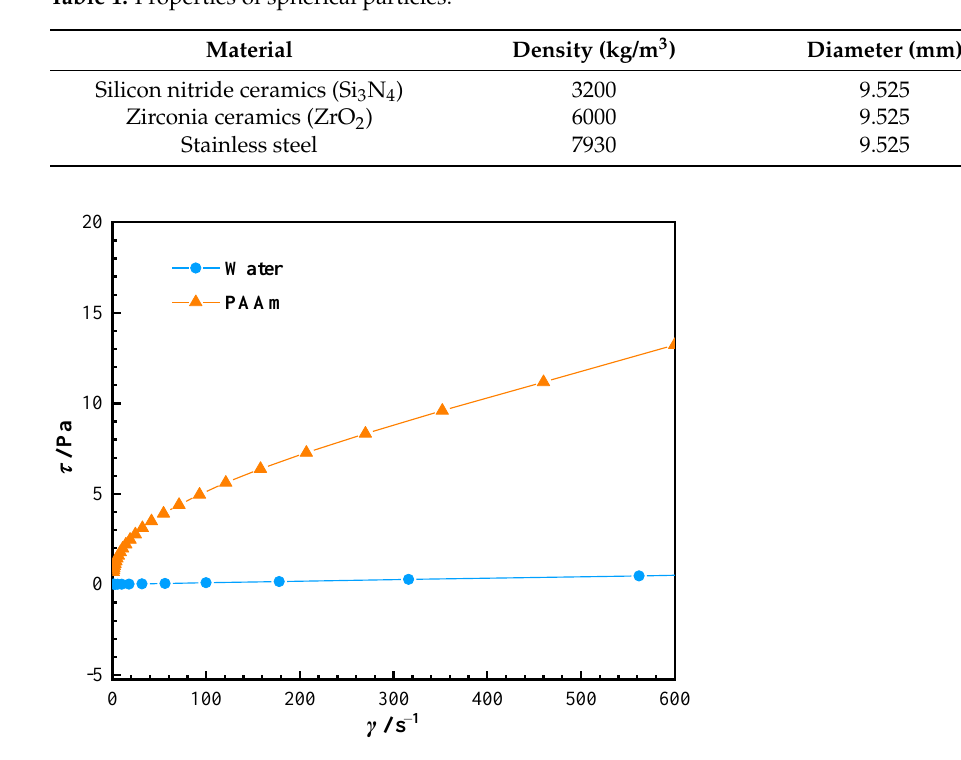
Figure 3. Rheogram of 0.5 wt% PAAm solution.